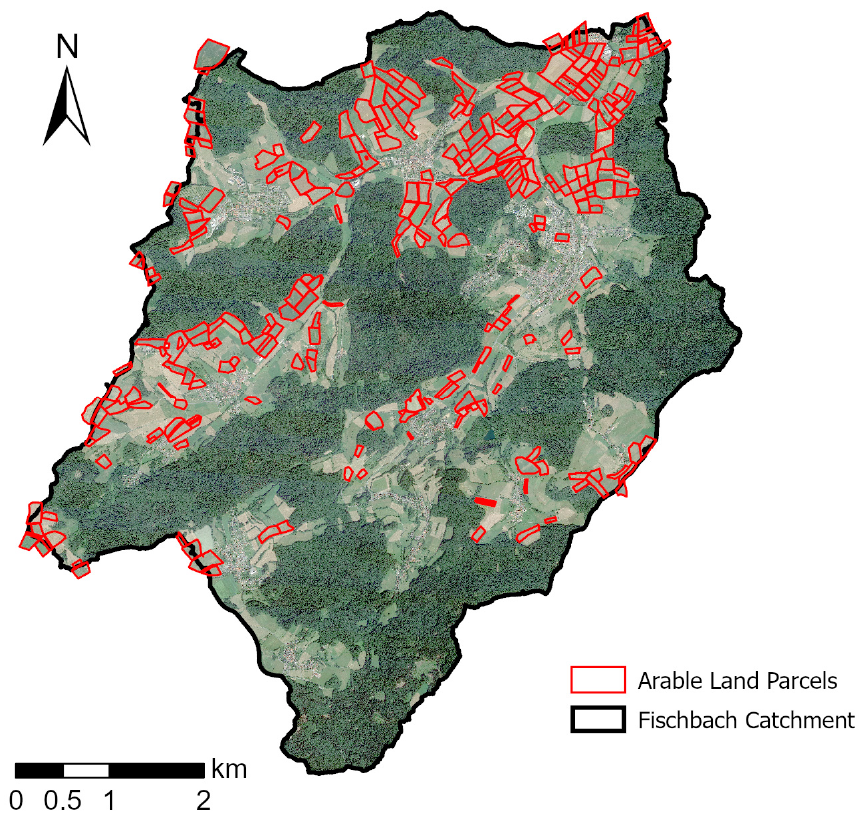
Figure 6. Geometries of arable land parcels in 2019 within the Fischbach catchment after data processing of mosaic on Google Earth™ images; data source: [30,40,41].